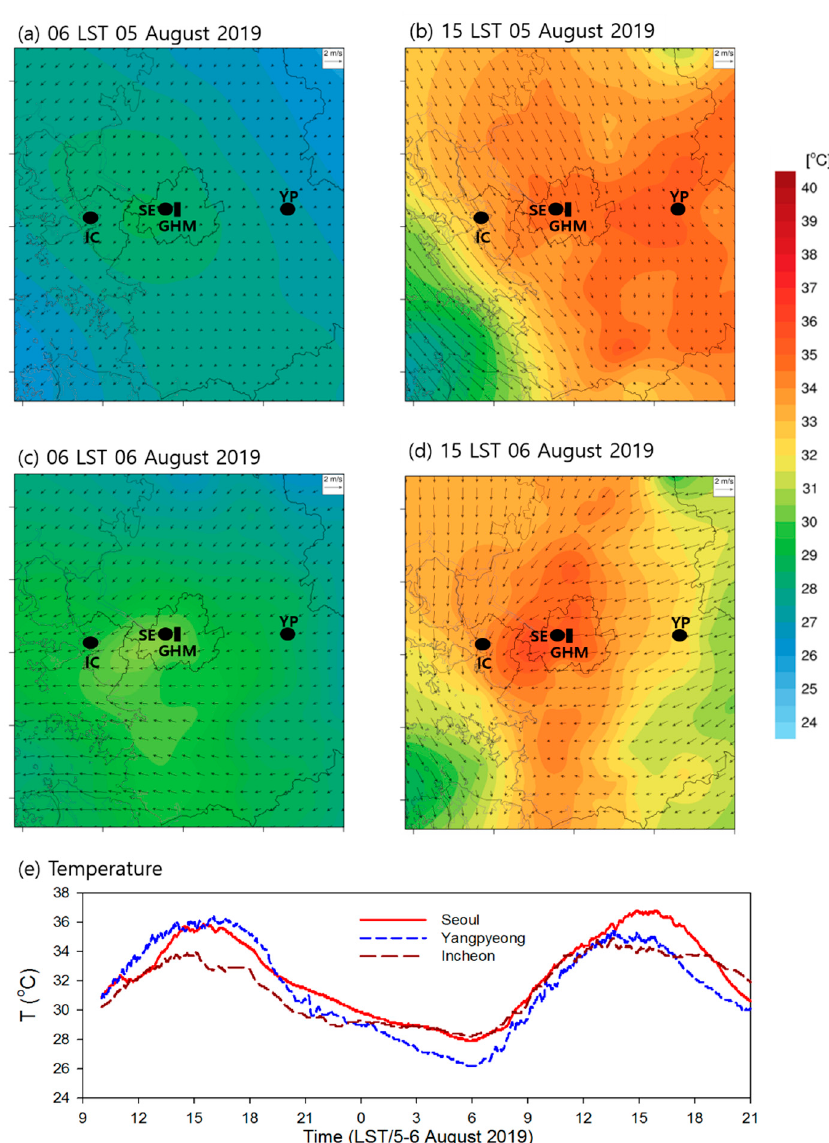
Figure 4. Horizontal distribution of air temperature and wind in Seoul Metropolitan Area at ( a ) 0600 LST, ( b ) 1500 LST on 05, ( c ) 0600 LST, and ( d ) 1500 LST on 06 August 2019, and ( e ) time series of air temperature observed at the Seoul (SE, red), Yangpyeong (YP, blue), and Incheon (IC, brown) automatic synoptic observation system (ASOS) stations. The location of the stations and the Gwanghwamun (GHM) campaign area are indicated by black filled circles and a rectangle, respectively.